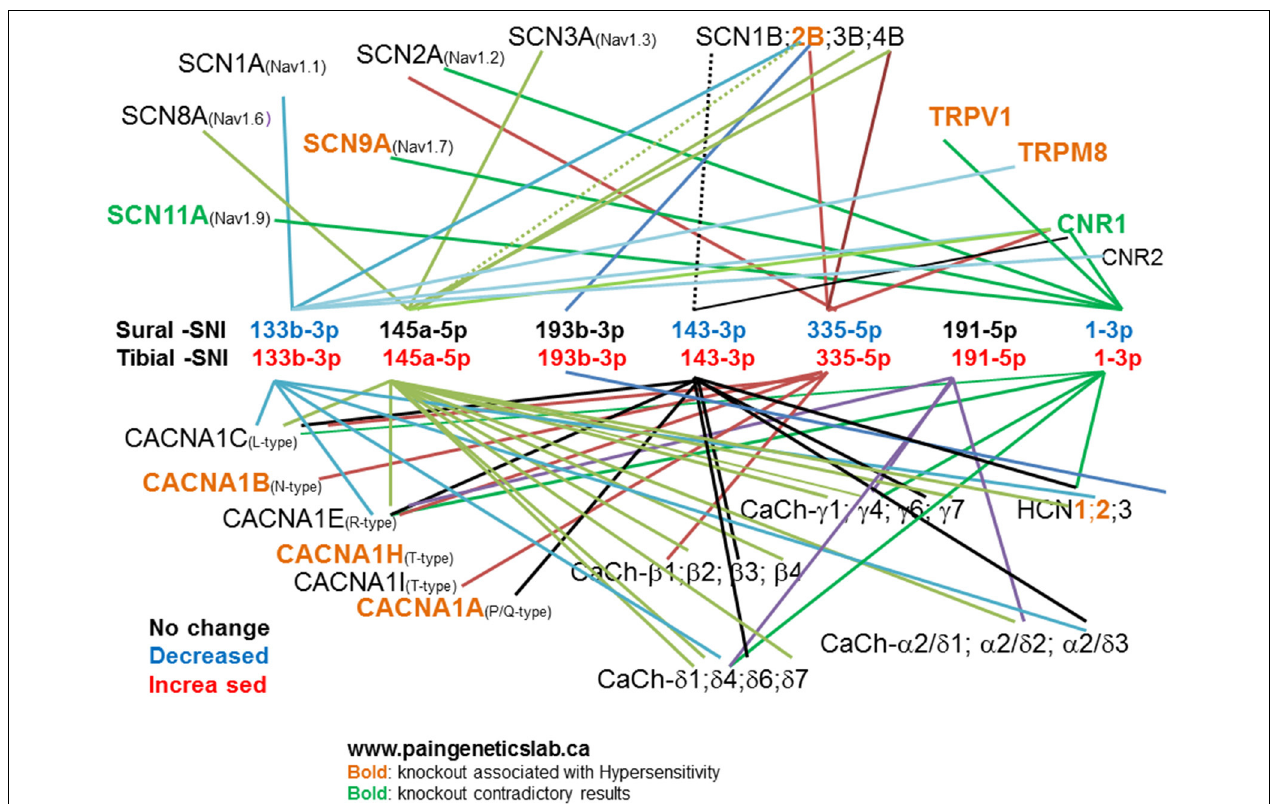
FIGURE 6 | Predicted mRNA targets for the identified miRs. TargetScan and Miranda software was used to identify potential mRNA targets for the identified miRs. The list of potential mRNA targets was filtered: by selecting those that encode for ion channels. Here we show those encoding for voltage-dependent sodium channels: α (SCN X A) and β (SCN X B) subunits; voltage-dependent calcium channels: α (CACNA1 X ), β (CaCh- β X ), γ (CaCh- γ X ), γ 2 δ X (CaCh- γ 2 δ X), and δ